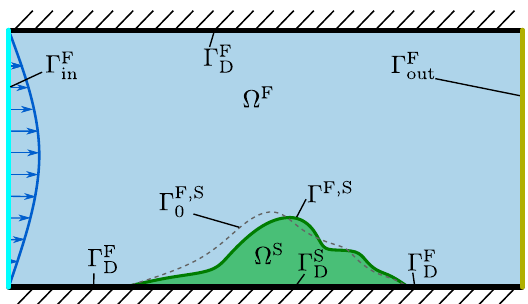
Fig. 2 Schematic of problem setup with domain and interface names. A biofilm (green domain) is grown on the flow cell floor and is interacting with a flowing liquid (blue domain) that is providing nutrients to and also deforming the biofilm which in return is changing the flow field. Undeformed (gray dotted line) and deformed biofilm interface. Inflow (teal) and outflow (yellow) boundaries of the flow cell model are also